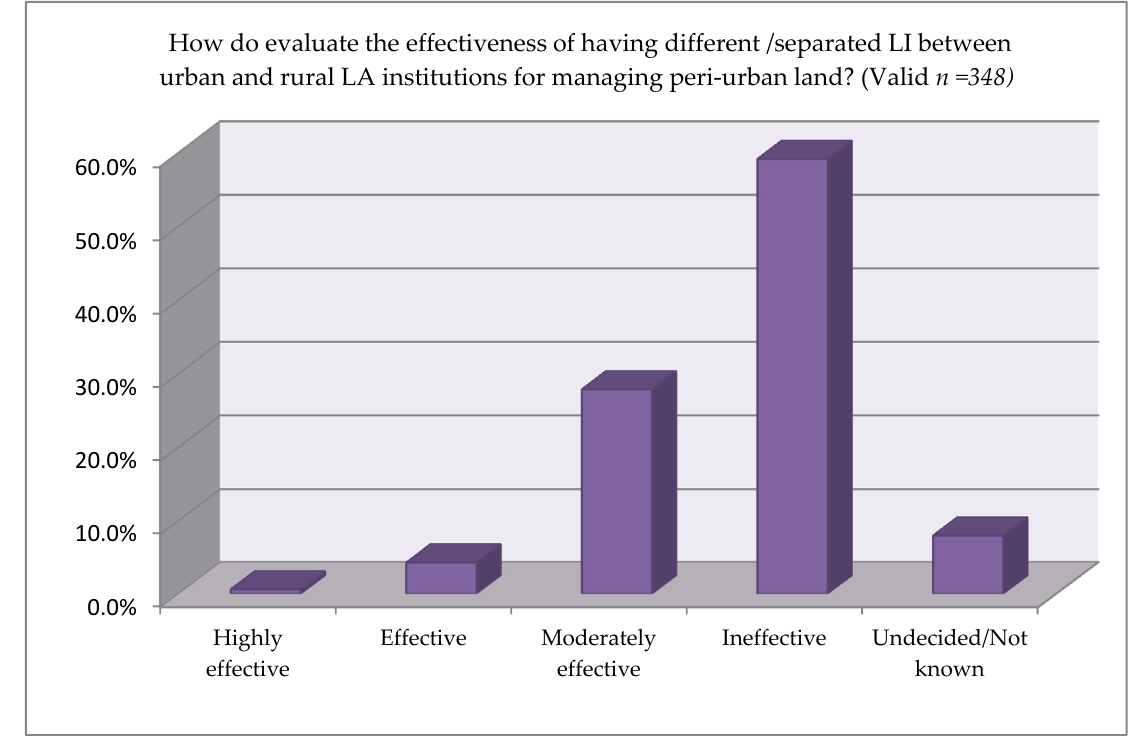
Figure 3. The responses of HH’s on the effectiveness of the existing LI for managing peri-urban land.